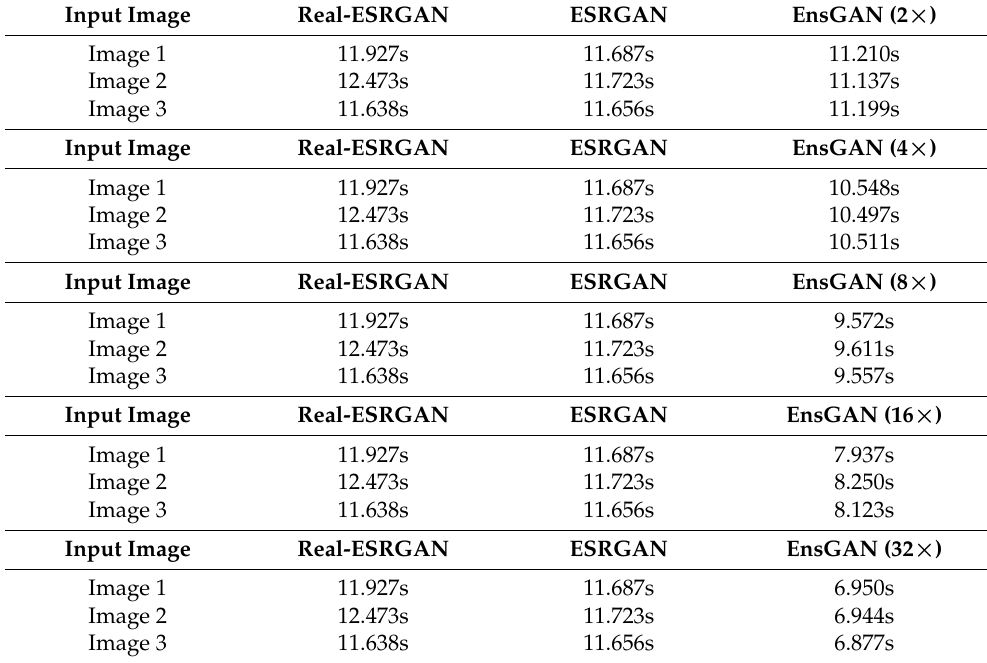
Table 2. Comparison of EnsGAN, ESRGAN, and Real-ESRGAN for speed process on Severstal Steel defect dataset. The defect samples of these three images are shown in Figure 8 in the following order: the top is image 1, the middle is image 2, and the bottom is image